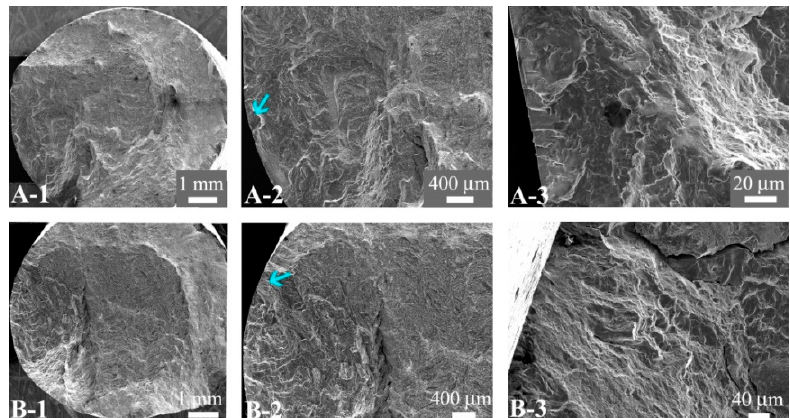
Figure 6. Fracture surface morphology of failed specimens under conventional fatigue test. A-1 ~ A-3: Specimen with N f = 1141 for rise and fall time 2 s; B-1 ~ B-3: Specimen with N f = 728 for rise and fall time 200 s. A-2 and B-2 are close-ups of A-1 and B-1, respectively; A-3 and B-3 are close-ups of the crack initiation regions where the arrows point to in A-2 and B2, respectively.